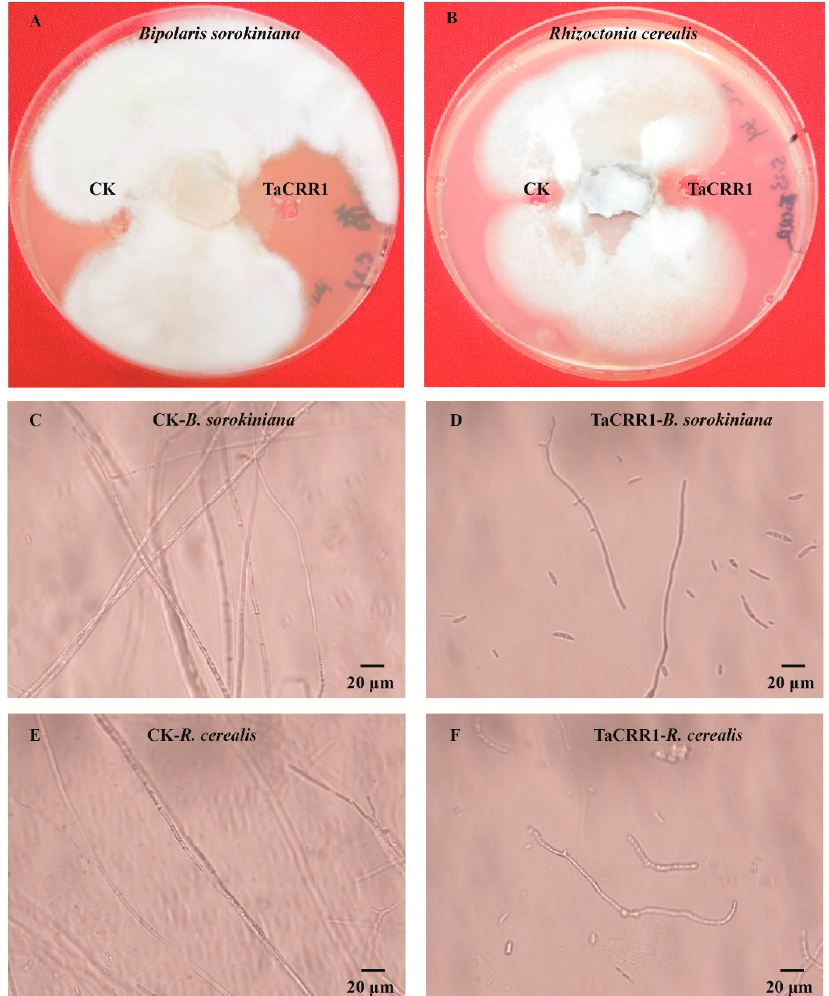
Figure 5. Antifungal activity assay of TaCRR1 against Bipolaris sorokiniana and Rhizoctonia cerealis . ( A ) Inhibiting e ff ect of TaCRR1 protein on the mycelia growth of B. sorokiniana . The fungal mycelia were treated by 1 µ mol L − 1 His-TF (CK) and His-TF-TaCRR1 for 5 days. ( B ) Inhibiting e ff ect of the TaCRR1 protein on the growth of R. cerealis mycelia. The fungal mycelia were treated by 1 µ mol L − 1 His-TF (CK) and His-TF-TaCRR1 for 5 days. ( C ) Photo by light microscopy (100 × ) of the hyphae of B.